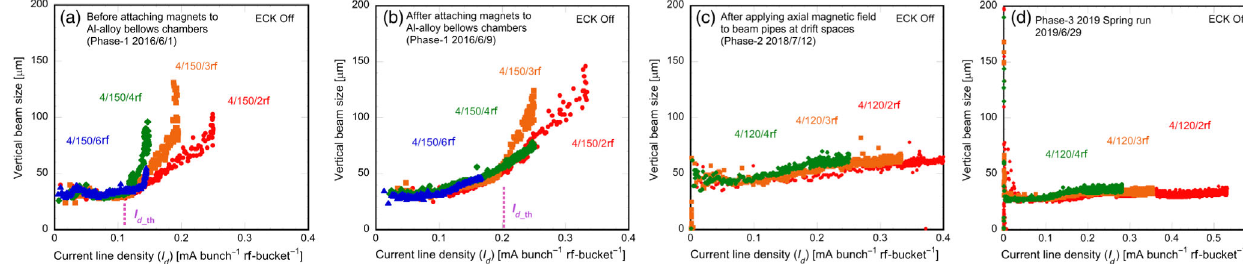
FIG. 20. Vertical beam sizes as a function of the current line density ( I d ) for several bunch filling patterns measured (a) before and (b) after attaching PM units to Al-alloy bellows chambers in Phase-1 commissioning, (c) Phase-2 commissioning, and (d) Phase-3 commissioning.